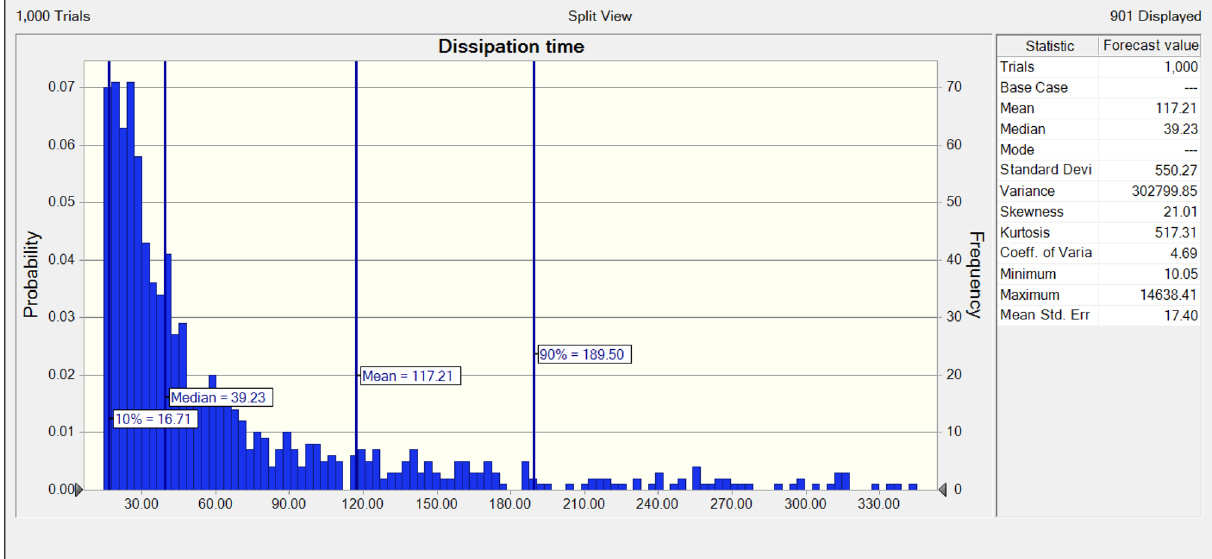
Fig. 12 Simulation results of dissipation time ( T